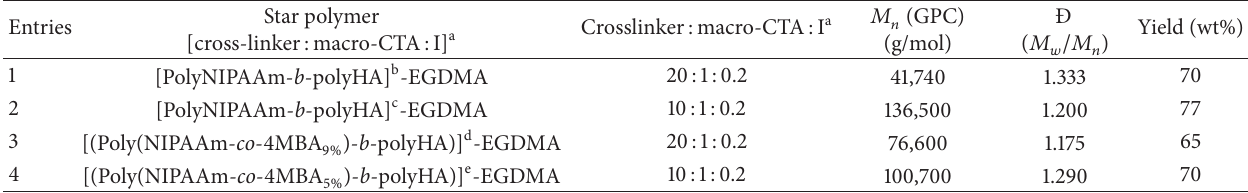
Table 3: Reactions for preparation of star polymers with a random number of arms and a cross-linked poly(EGDMA) core. Star polymer Entries [ cross-linker:macro-CTA:I]